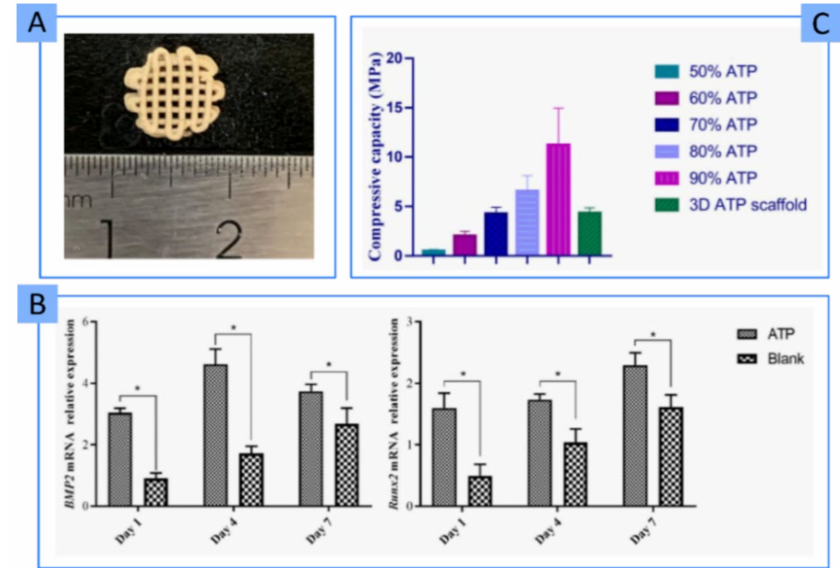
Figure 22. ( A ) Photograph of the PAL 3D printed scaffold. ( B ) mRNA expression of BMP2 and Runx2 genes quantified by real-time RT-PCR ( p -value < 0.05). ATP stands for “PAL” and Blank stands for “control group” indicating that those rats did not receive any treatment. ( C ) Compressive strength of PAL scaffolds at different concentrations of clay minerals. Figures adapted from [90], Dove